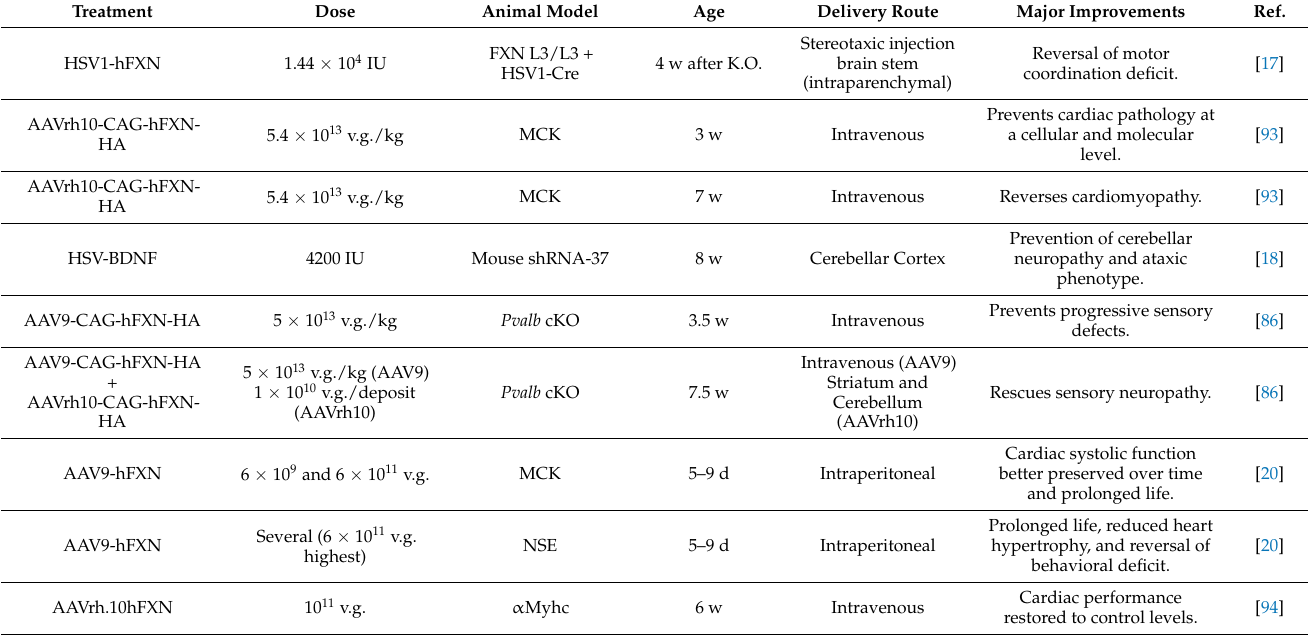
Table 5. The history of in vivo Friedreich’s Ataxia gene therapy. Treatment Dose Animal Model Age Delivery